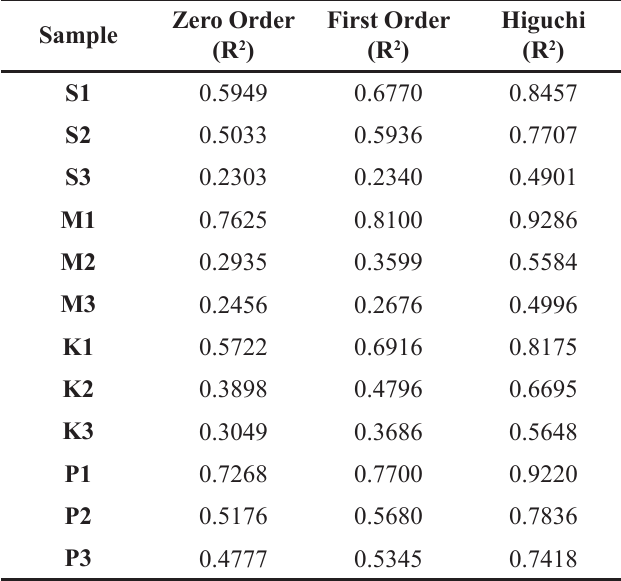
TABLE VI - Release kinetics data of CA and its formulations